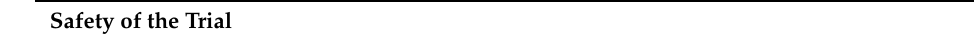
Table 5. Safety of the JenaMACS trial. Any of the mentioned adverse events (AE) is considered as a serious adverse event (SAE) if it is directly caused, may have caused in the past or may cause in the future death or a serious aggravation of the state of health of a patient, user or another person if the incident was caused by the medical device. The events will be recorded from the moment the medical device is unpacked and inserted into the patient until follow-up at